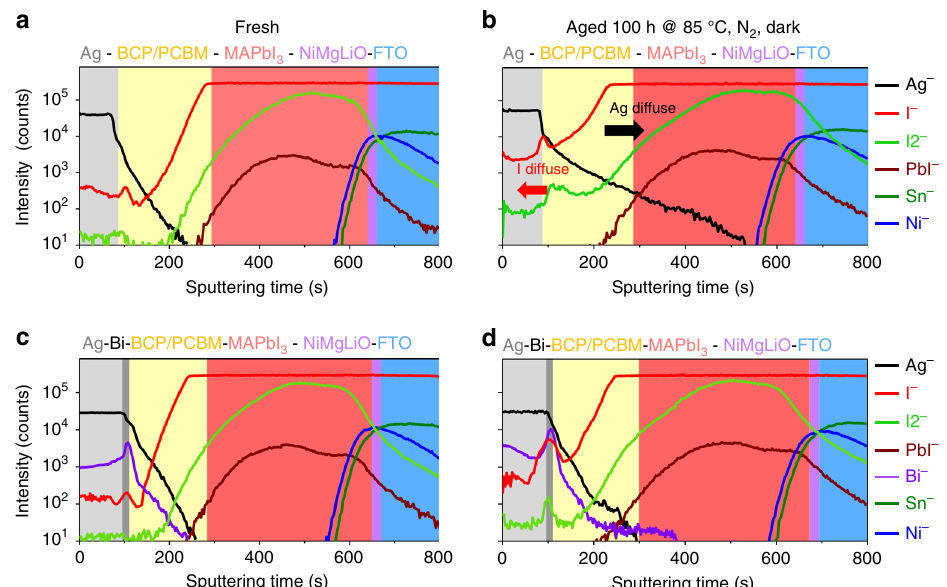
Fig. 4 Elemental distribution in HPVKSCs. ToF-SIMS elemental depth pro fi les of MA-HPVKSCs. a and c are the fresh devices with and without a Bi interlayer with a thickness of 20 nm; b and d are those two devices aged at 85 °C for 100 h in the dark under N 2 atmosphere. Source data are provided as a Source Data fi